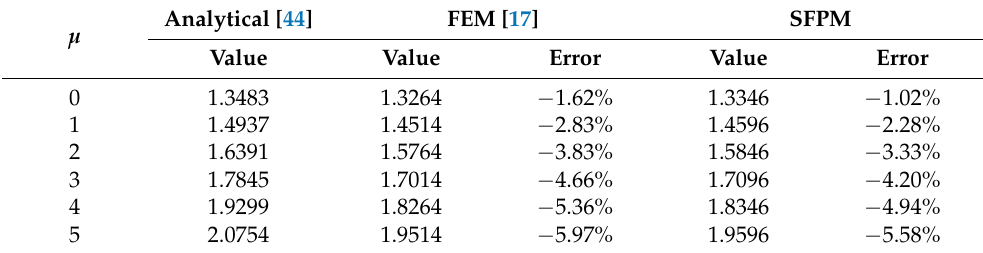
Table 2. Comparison of the results of SFPM with those of analytical method and